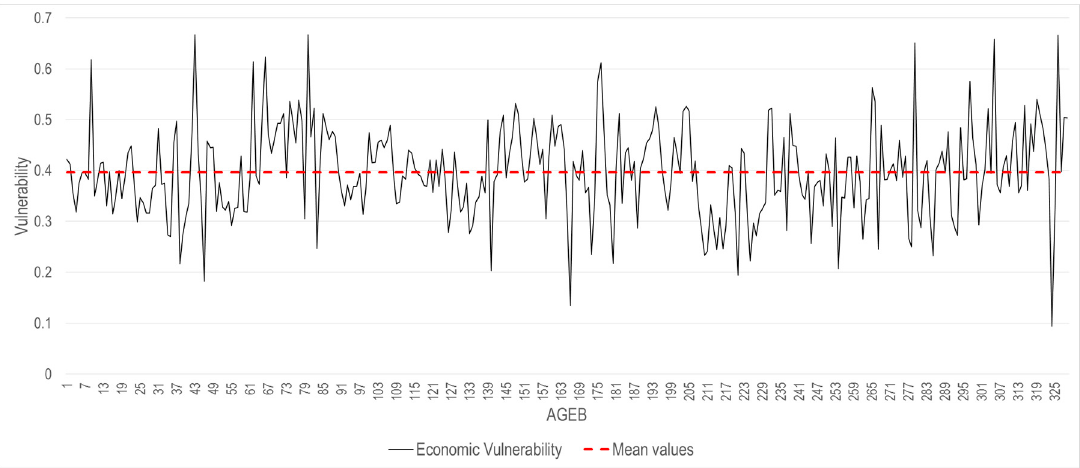
Figure 5. Economical vulnerability values for the studied AGEB.